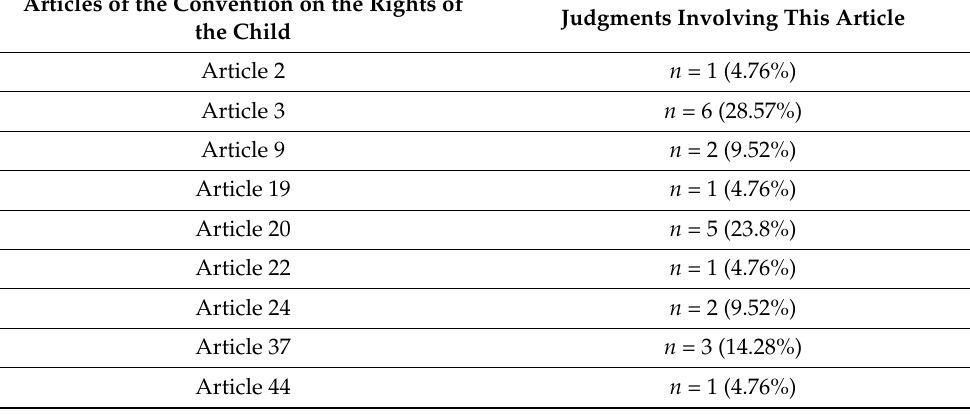
Table 3. Frequencies of Articles of the UN Convention on the Rights of the Child involved in the n = 21 judgments under